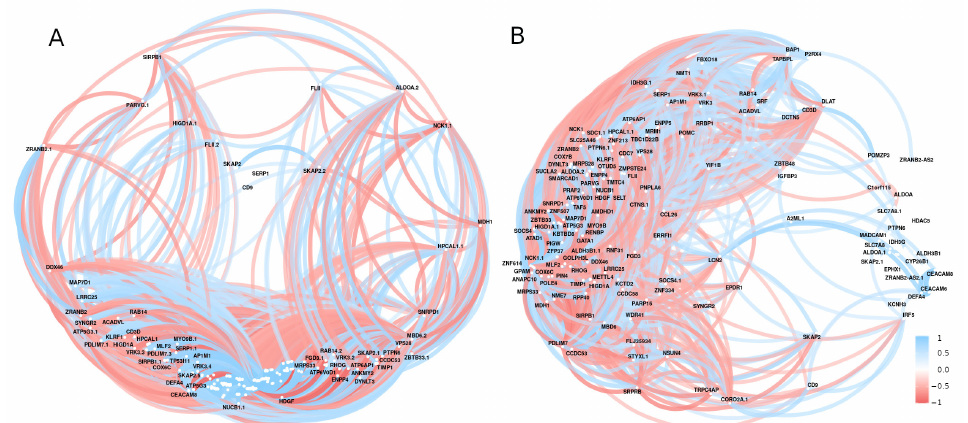
Figure 8. The correlation network of the expressed genes by using GSE15932 and GSE55098 (group A ) and GSE30208 (group B ). Positive (blue) or negative (red) correlations are indicated by links between genes. Correlations with r < 0.5 or with p -value > 0.01 were